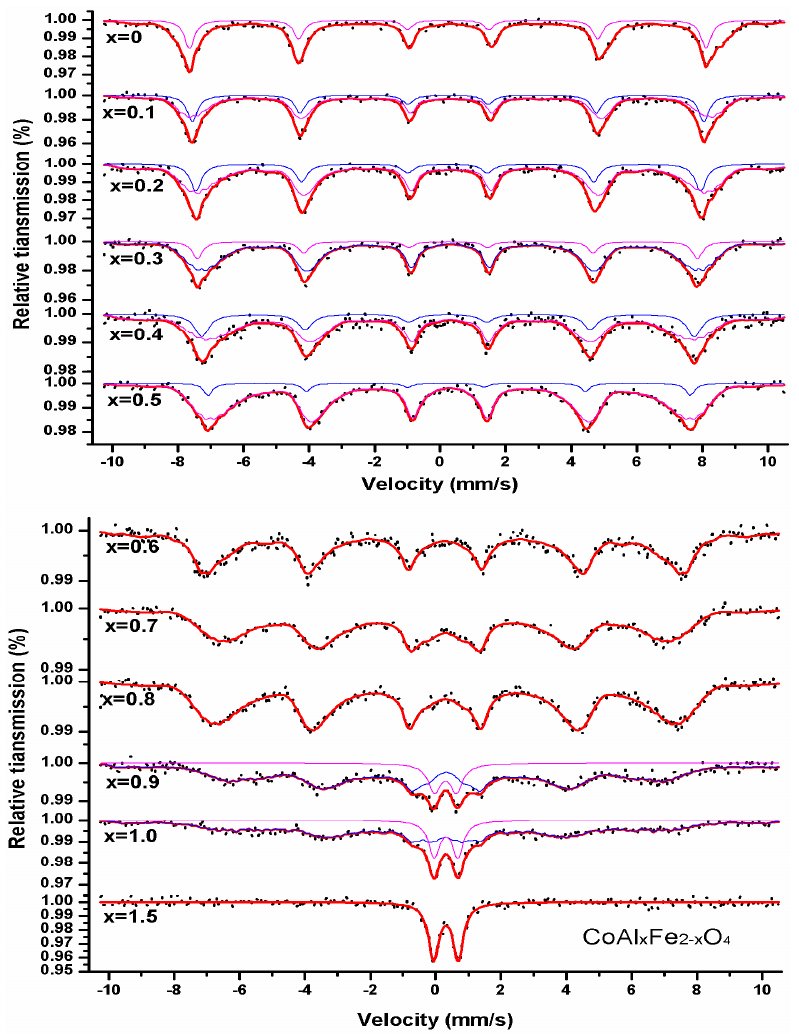
Figure 6. Mössbauer spectra of CoAl x Fe 2- x O 4 samples calcined at 1000 °C.